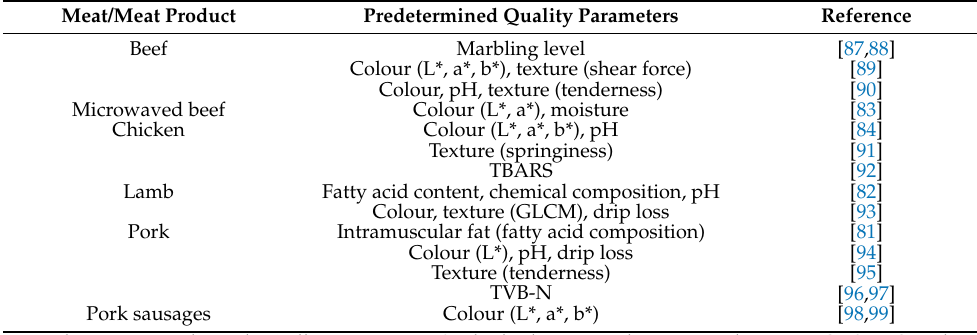
Table 2. Application of hyperspectral imaging for meat quality